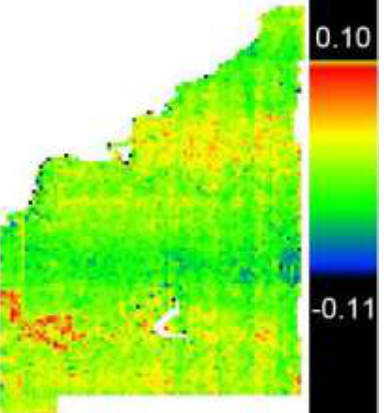
Figure 12. Averaged y-parallaxes, Pleiades stereo model